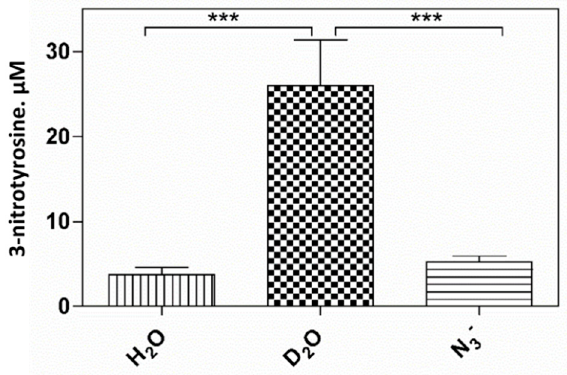
Figure 7. Photooxidation of tyrosine by the nitrite/pheomelanin/UVB system: effect of D 2 O and NaN 3 . Pheomelanin 4.2 μ g/mL is added to the solution, containing 1 mM tyrosine, 10 mM K-nitrite in 0.2 M K-phosphate buffer at pH 5.5 and 0.1 mM DTPA. The solution is exposed to UVB rays for 30 min. The reaction is stopped by placing the mixture in the dark and the supernatant, obtained after centrifugation, is analyzed by HPLC to determine the formation of 3-nitrotyrosine, as reported in Materials and Methods. In D 2 O, the pD (5.5) was taken as the measured pH + 0.4. NaN 3 is added to a final concentration of 1 mM. *** p < 0.001.